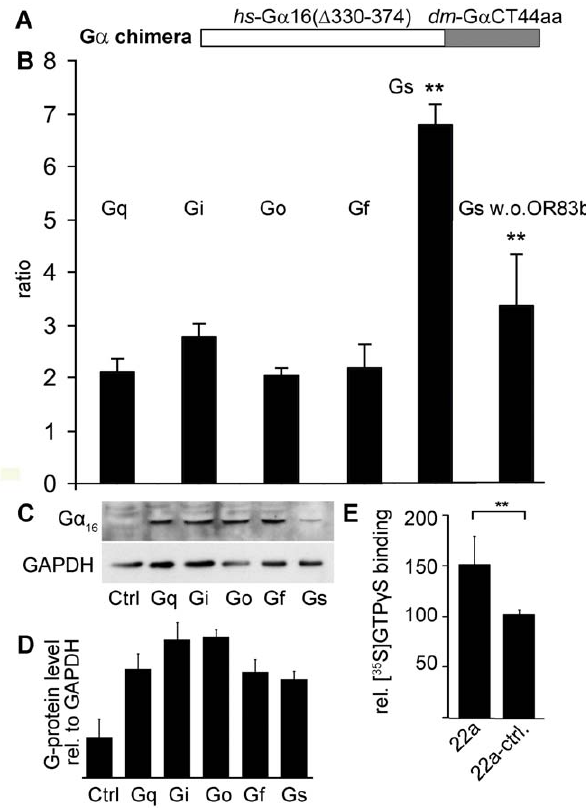
Figure 4. Role of G-proteins in signaling of recombinantly expressed olfactory receptors. ( A ) Chimeric construct with N- terminus of human G a 16 and the C-terminus of Drosophila G a -proteins. ( B ) Ratio of transfected HEK293 cells responding to 500 m M cyclohex- anone in Ca 2 + imaging experiments; cells either express OR43a, OR83b and the respective G-protein chimera, OR43a alone and the respective G-protein chimera, or OR43a, OR83b and full length human G a 16 . An increase in the ratio means that more cells responded upon co- expression of the G-protein chimera (n . 5 independent transfections). The ratio determined with the G a s chimera was compared to the ratios obtained with the other G-protein chimera and was found to be signify- cantly different from all of them. ( C ) Western blot detection of recombinantly expressed G-protein chimera with an antibody against G a 16 , equal amounts of protein was loaded per lane (controlled by GAPDH detection), control (ctrl) were non-transfected HEK293 cells. ( D ) Quantification of western blot analysis by densiometry, G-protein and GAPDH bands were ana-lyzed from cell preparations from 3 indepen- dent transfections. Band intensities originating from G a 16 stained membranes were divided by band intensities from GAPDH stained membranes. The small differences between the intensities from the different chimera were not significant (tested with Student’s t -test). ( E ) [ 35 S]GTP c S binding to membrane preparations upon odorant stimu- lation, cells were transfected with ORs and G a -protein, control cells were mock transfected. The reaction was carried out in triplicates. s.e.m.